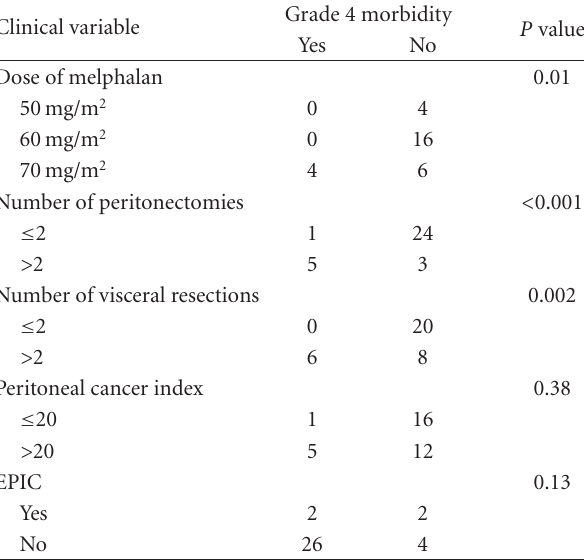
Table 2: Univariate analysis of clinical factors associated with grade 4 postoperative morbidity in 34 patients treated with cytoreductive surgery and HIPEC with